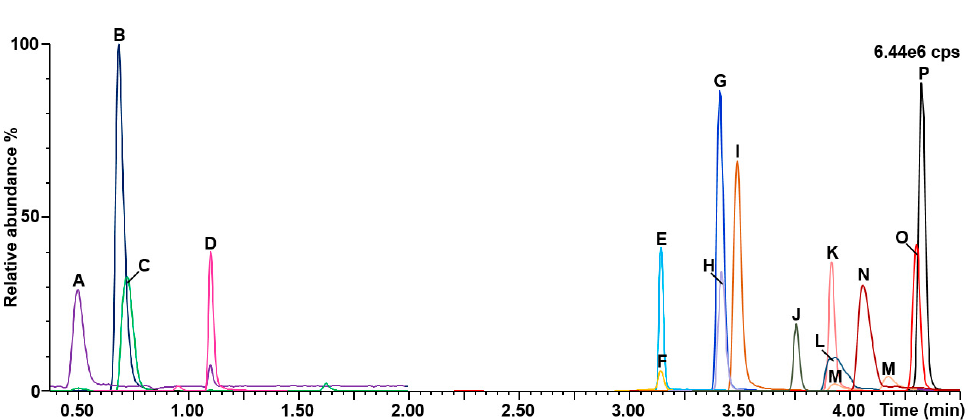
Figure 4. Chromatograms obtained for the organic acids second-tier test. A: Creatinine; B: Guanidineacetic acid; C: Crea- tine; D: Uracil; E: 3-hydroxypropionic acid; F: 3-hydroxyglutaric acid; G: glutaric acid; H: propionylglycine; I: 3-hydroxy- isovaleric acid; J: homogentisic acid; K: orotic acid; L: malonic acid; M: 2-methylcitric acid; N: methylmalonic acid; O: 3- methylcrotonylglycine; P: isovalerylglycine; cps: counts per second.